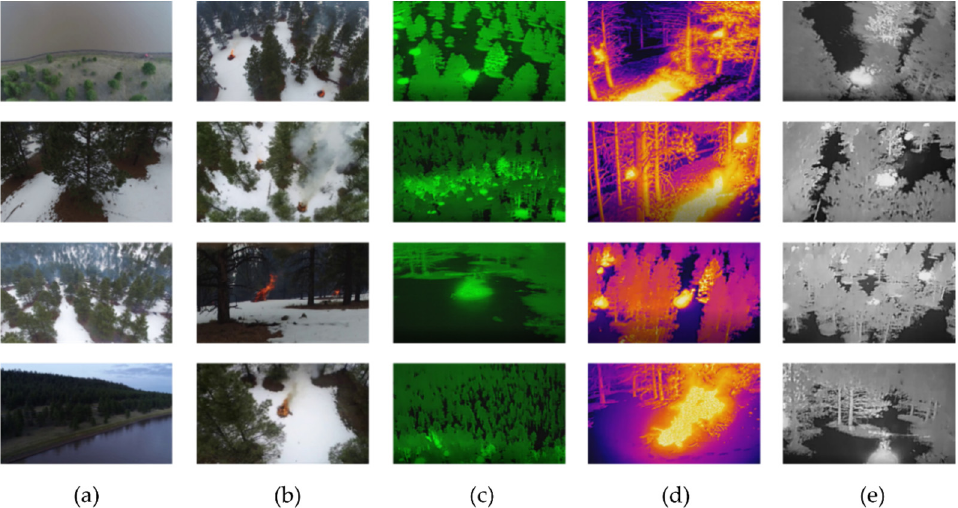
Figure 1. Frame samples of different videos: ( a , b ) normal spectrum palette; and ( c – e ) heatmaps, including GreenHot, Fusion, and WhiteHot palettes.